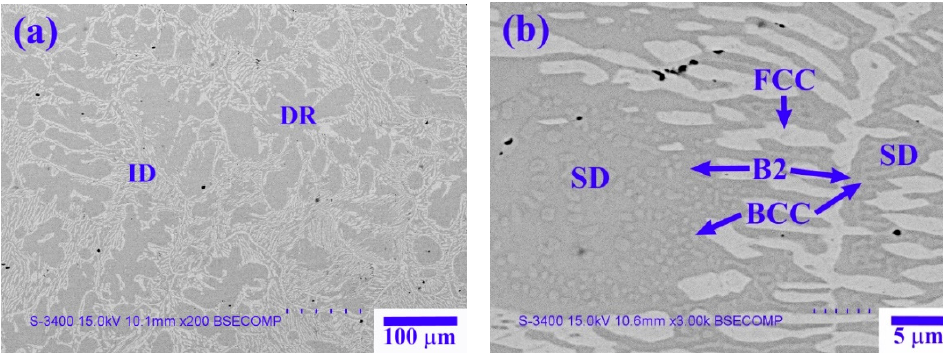
Figure 8. SEM-BSE images of the X 1 as-cast alloy: ( a ) low magnification; ( b ) high magnification.